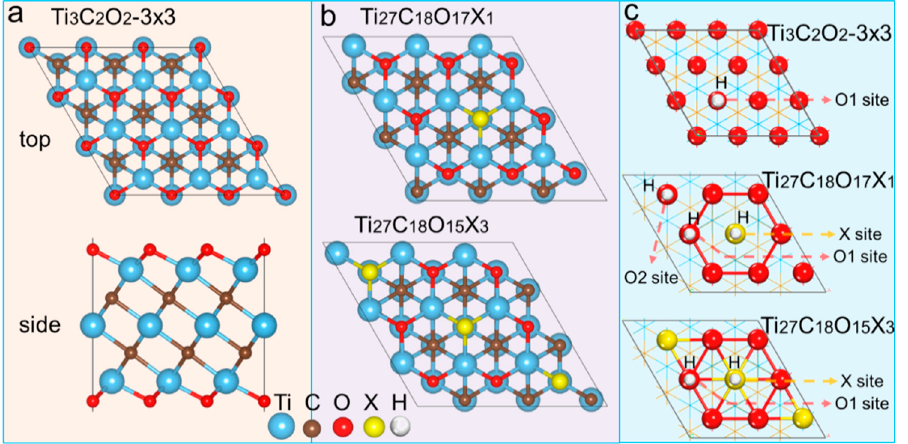
Figure 1. Structure diagram and Δ G H . ( a ) Two-dimensional (2D)-Ti 2 CO 2 (Ti 27 C 18 O 18 ) of 3 × 3 supercell and ( b ) Ti27C18O17X and Ti 27 C 18 O 17 X 3 doped with different concentrations of X (X = S, Se, and Te), and ( c ) corresponding H equivalent adsorption sites X, O1, and O2.